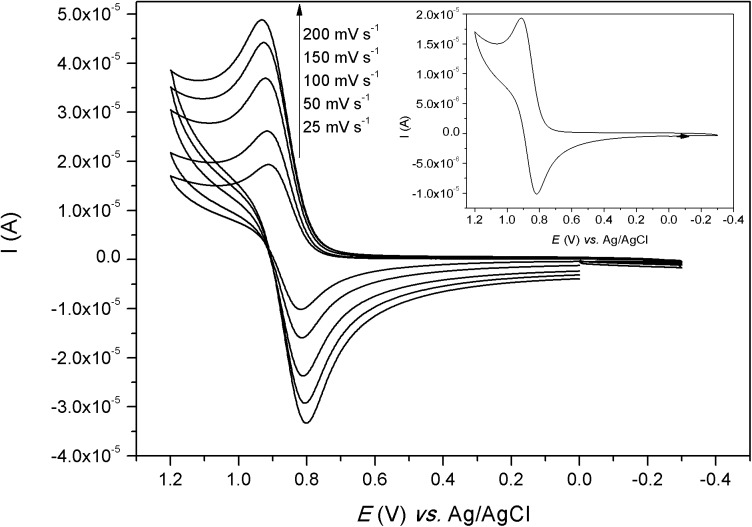
Cyclic voltammogram of [Ni(HL)](ClO4)2, in water.K3[Fe(CN)6] (E
1/2 = 0,254 V versus Ag/AgCl; ΔE = 347 mV) was used as internal standard. Inlet: voltammograms at 25 mV s-1.